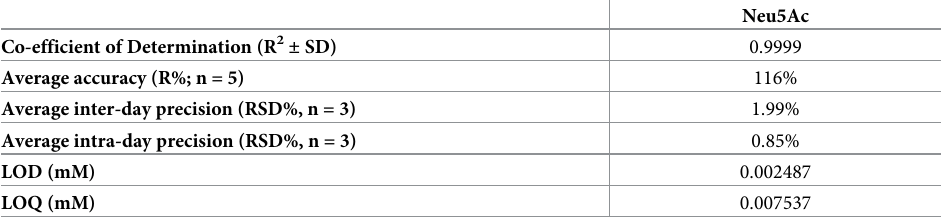
Table 1. Summary of the correlation coefficient, accuracy, precision, LOD and LOQ values for the proposed method.